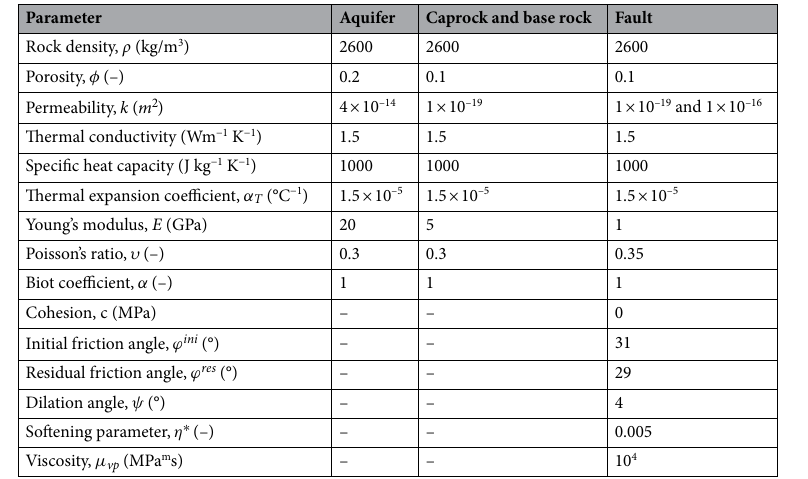
Table 1. Material properties of different rock types used in the model.